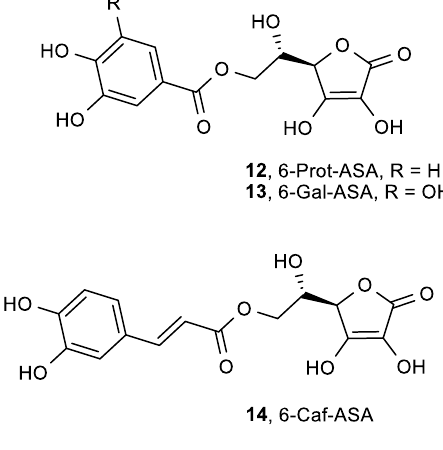
Figure 6. ASA phenolic esters.